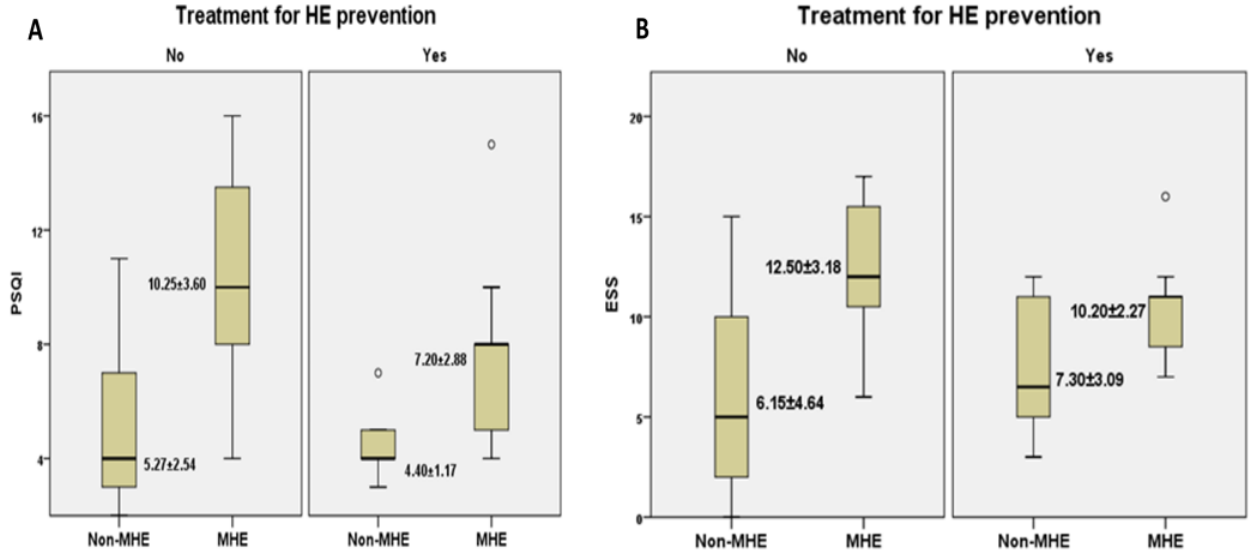
Figure 2. The relationship between MHE and self-reported questionnaires’ mean score: PSQI ( A )